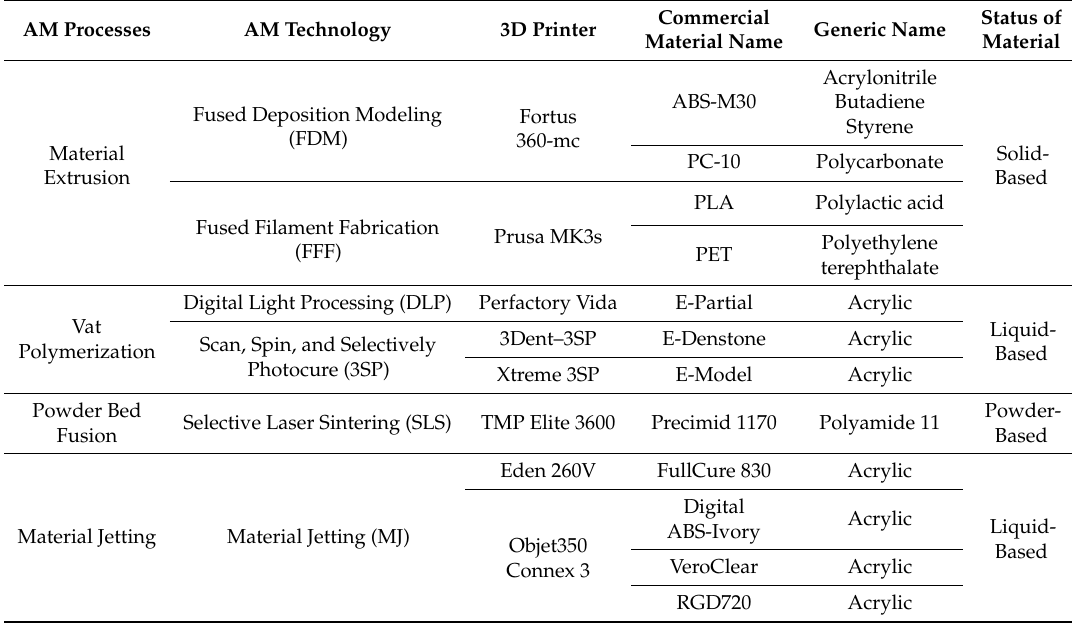
Table 2. Selected polymer materials.